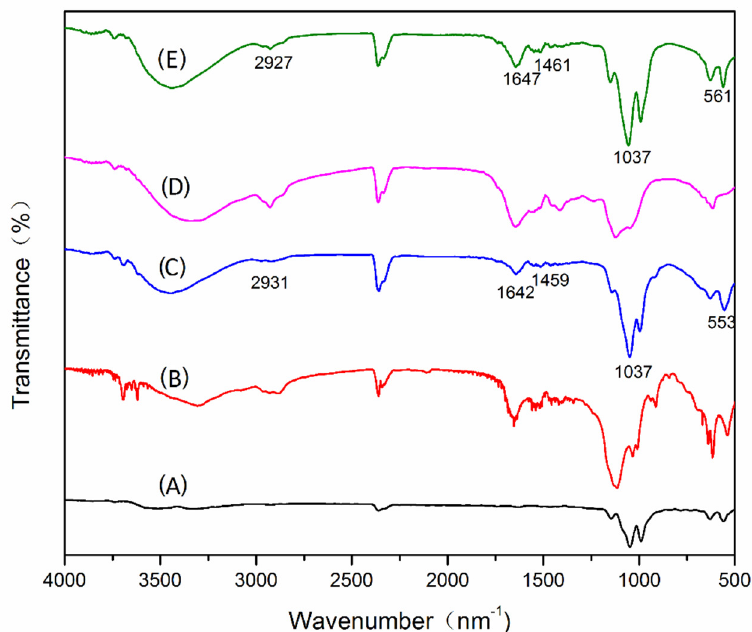
Figure 2. FT − IR spectra of ( A ) Cu 3 (PO 4 ) 2 · 3H 2 O; ( B ) free alcalase; ( C ) ACHNs; ( D ) free dispase; and ( E )